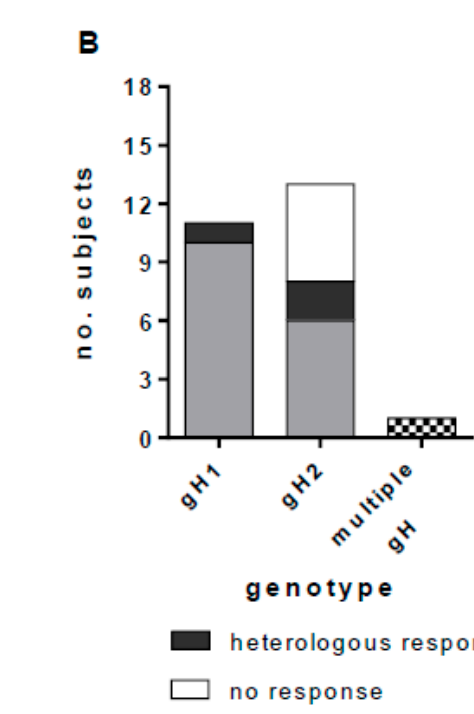
Figure 8. Genotype-specific IgG antibody to gB and gH in subjects with non-primary HCMV infection. ( A ) gB genotype-specific IgG response in subjects infected by gB1-HCMV, gB2/3-HCMV or gB4-HCMV or multiple genotype HCMV strains (gB2/3 and gB4 are grouped together, since the antibody response to these genotypes was cross-reactive). ( B ) gH genotype-specific IgG response in women infected by gH1-HCMV, gH2-HCMV or multiple genotype HCMV strains.